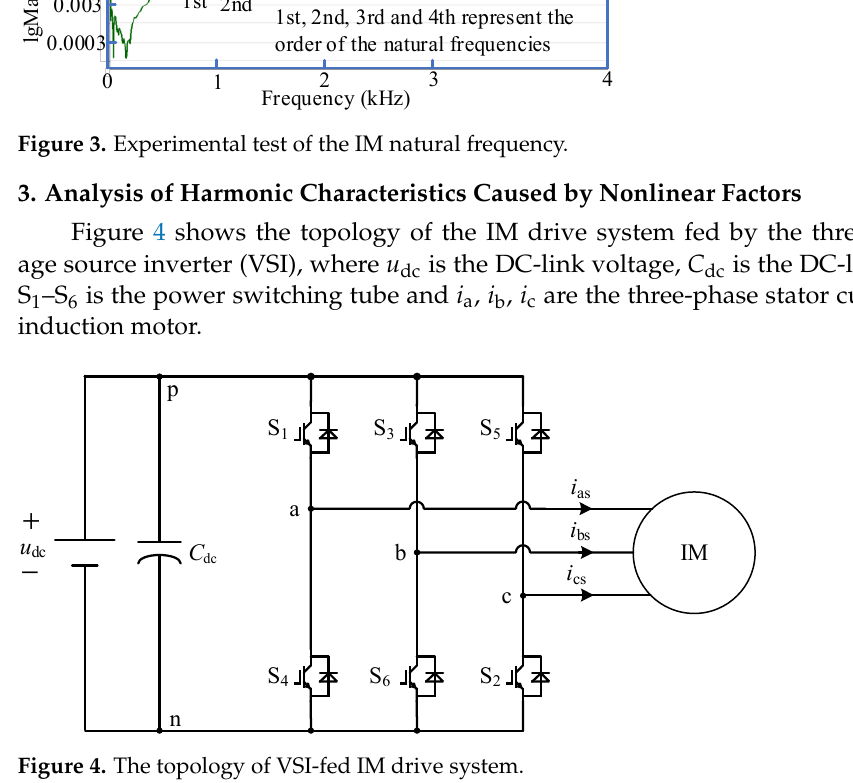
Figure 4. The topology of VSI-fed IM drive system.